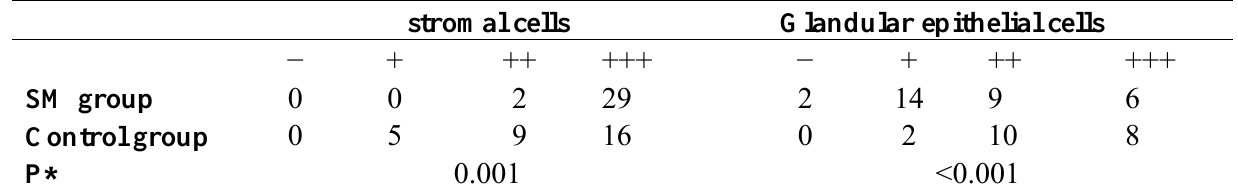
Table 2. Staining score with NF- κ B in decidual stromal cells and decidual glandular epithelial cells.